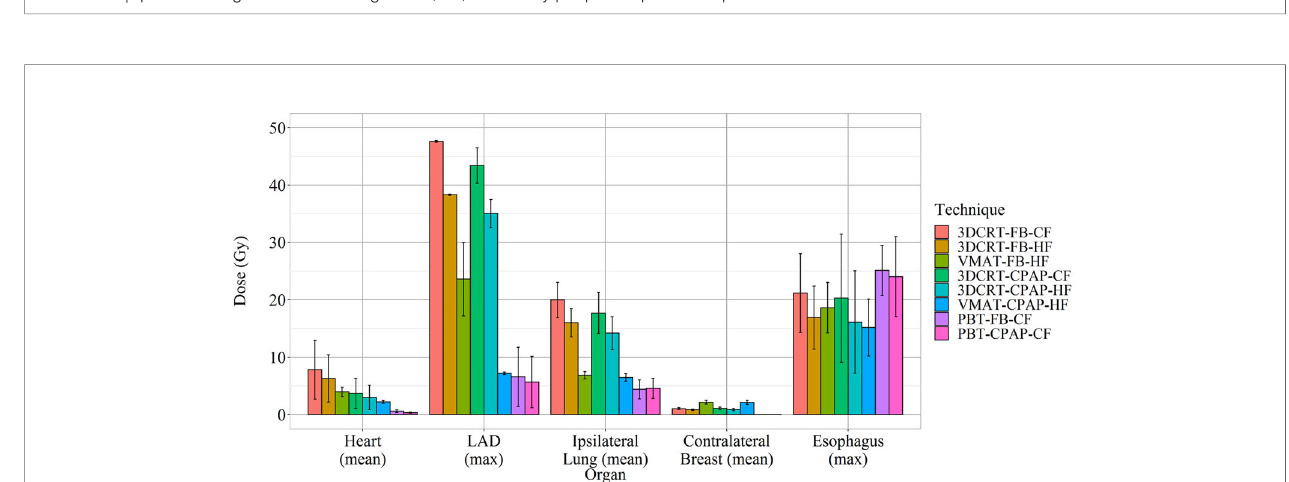
FIGURE 4 | Ipsilateral lung volumes receiving over 5, 20, and 30 Gy per patient per technique.